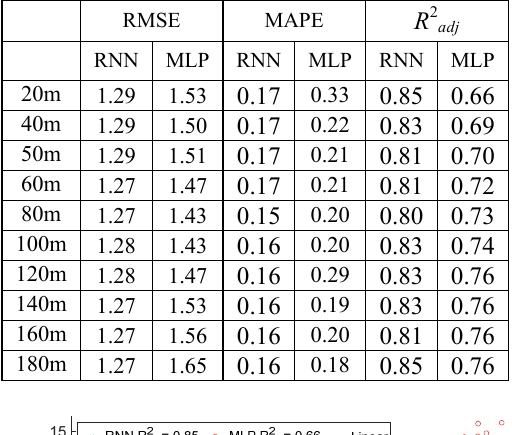
RMSE MAPE R 2 adj RNN MLP